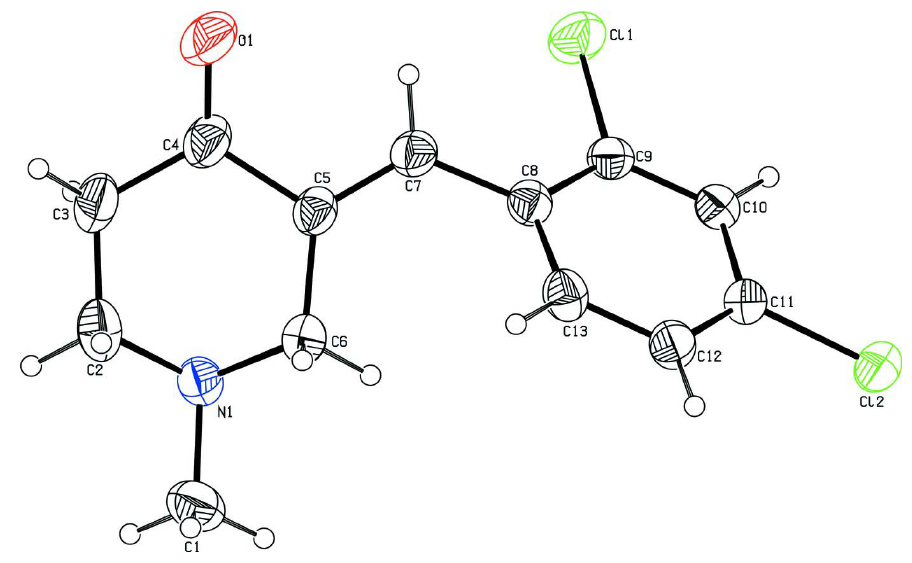
Figure 1 The molecular structure of the title compound, showing 30% probability displacement